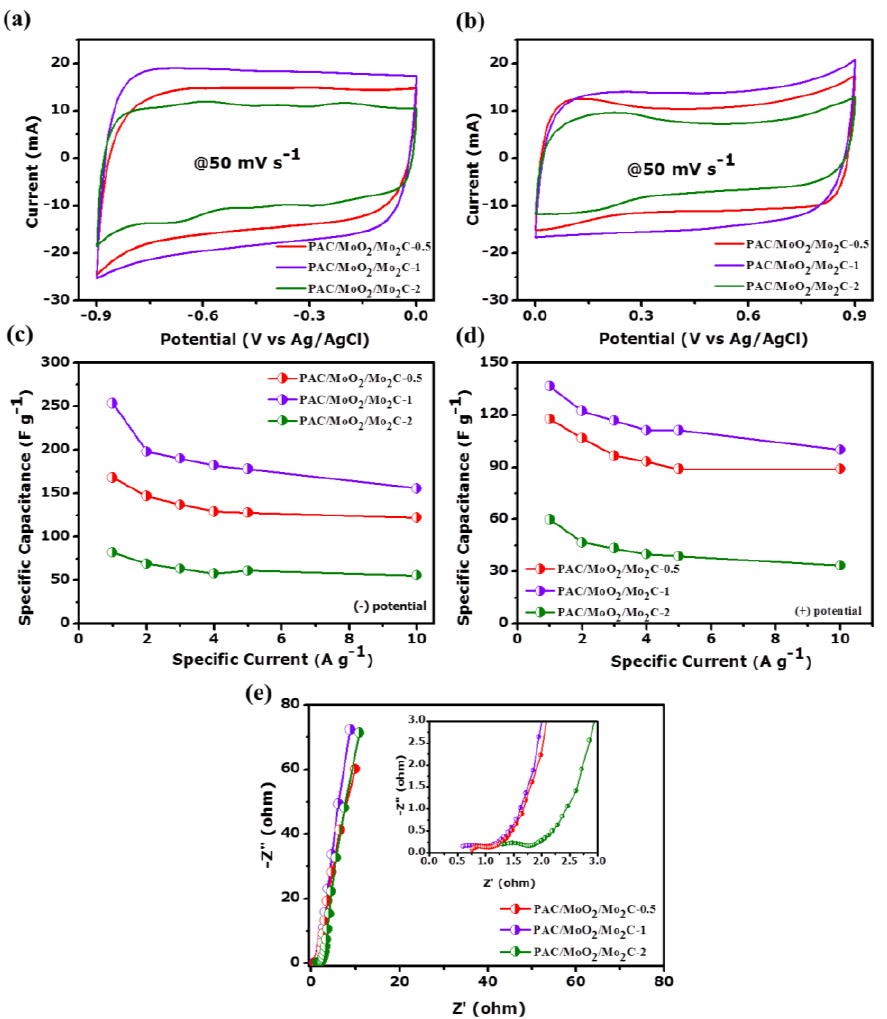
Figure 8. ( a , b ) Cyclic voltammetry at scan rate of 50 mV s − 1 , ( c , d ) specific capacitance at different specific current values in (−0.9–0.0 V) and (0.0–0.9 V) operating potential windows and ( e ) Nyquist plots of the PAC/MoO 2 /Mo 2 C ternary composites in a three-electrode configuration.